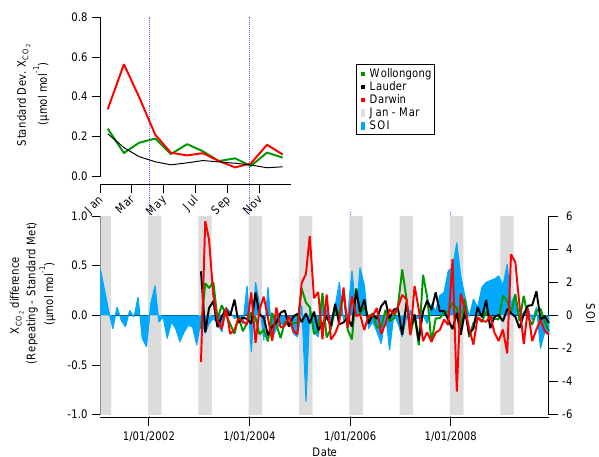
Figure 10. (Bottom) The monthly mean time series of differences with fixed 2001 or year specific mete- between simulated X CO 2 orology, and (top) the standard deviation resulting from deriva- tion of the MSC of these differences, representing the influence of interannual variability in dynamics on the interannual variabil- ity in X CO . The Southern Oscillation Index (accessed from http: 2 //www.cpc.ncep.noaa.gov/data/indices/soi) is shown in